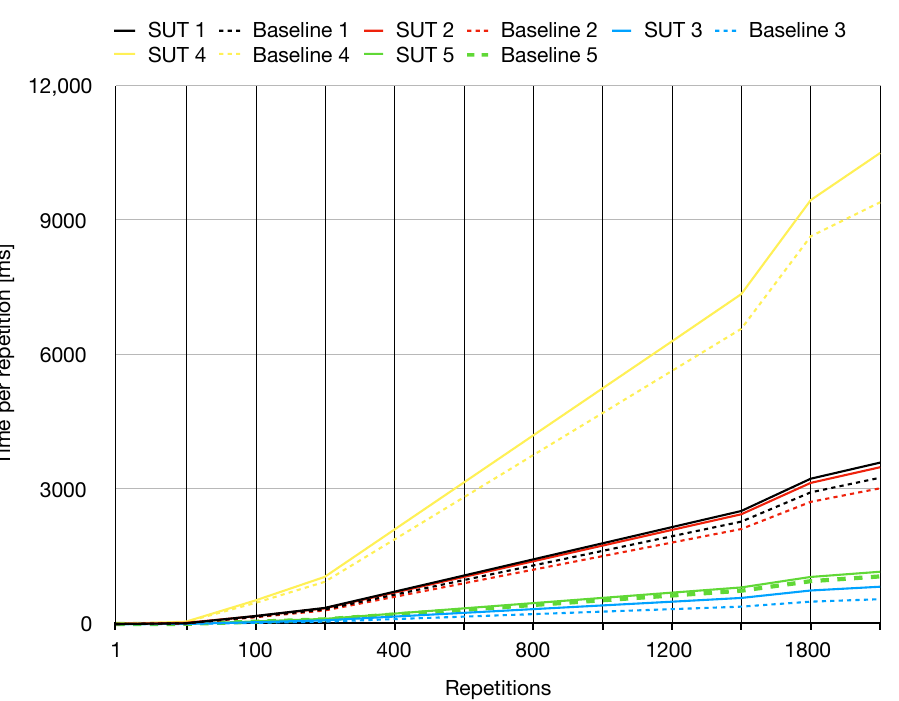
Figure 12. Repeated execution test codes for a high-level sentence to acquire a light sample. The high- level hardware-driving code and its oracle is put in the internal loop and statistics are updated. The external loop increments the upper limit of the inner loop by 100. The word tick acquires the current value of the timer. The timer value is fetched at the start and at the end of the internal loop to obtain the execution time by difference.